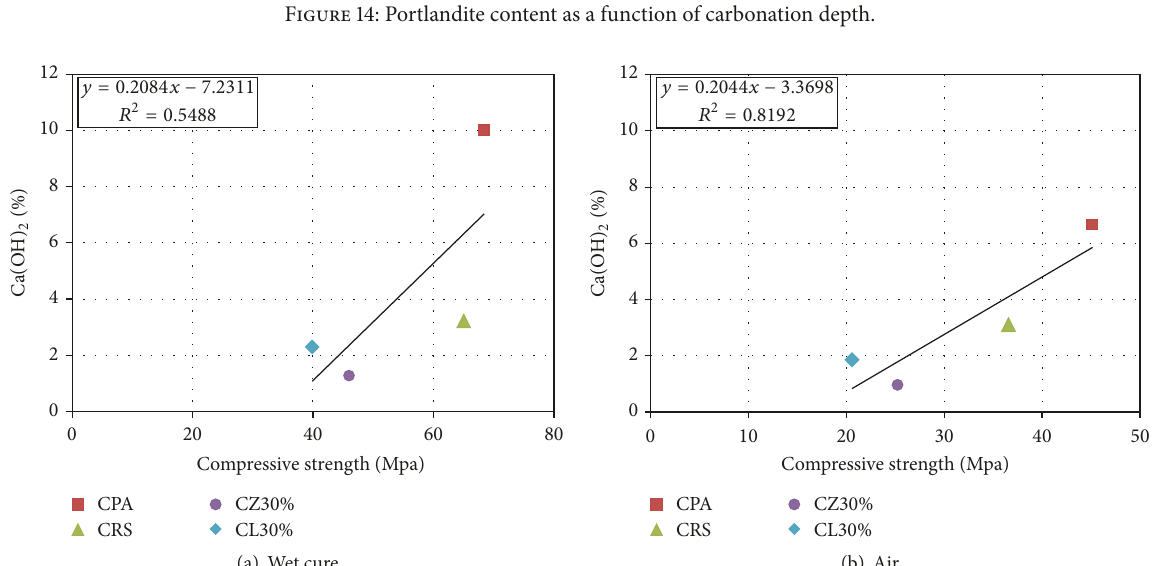
Figure 14: Portlandite content as a function of carbonation depth.